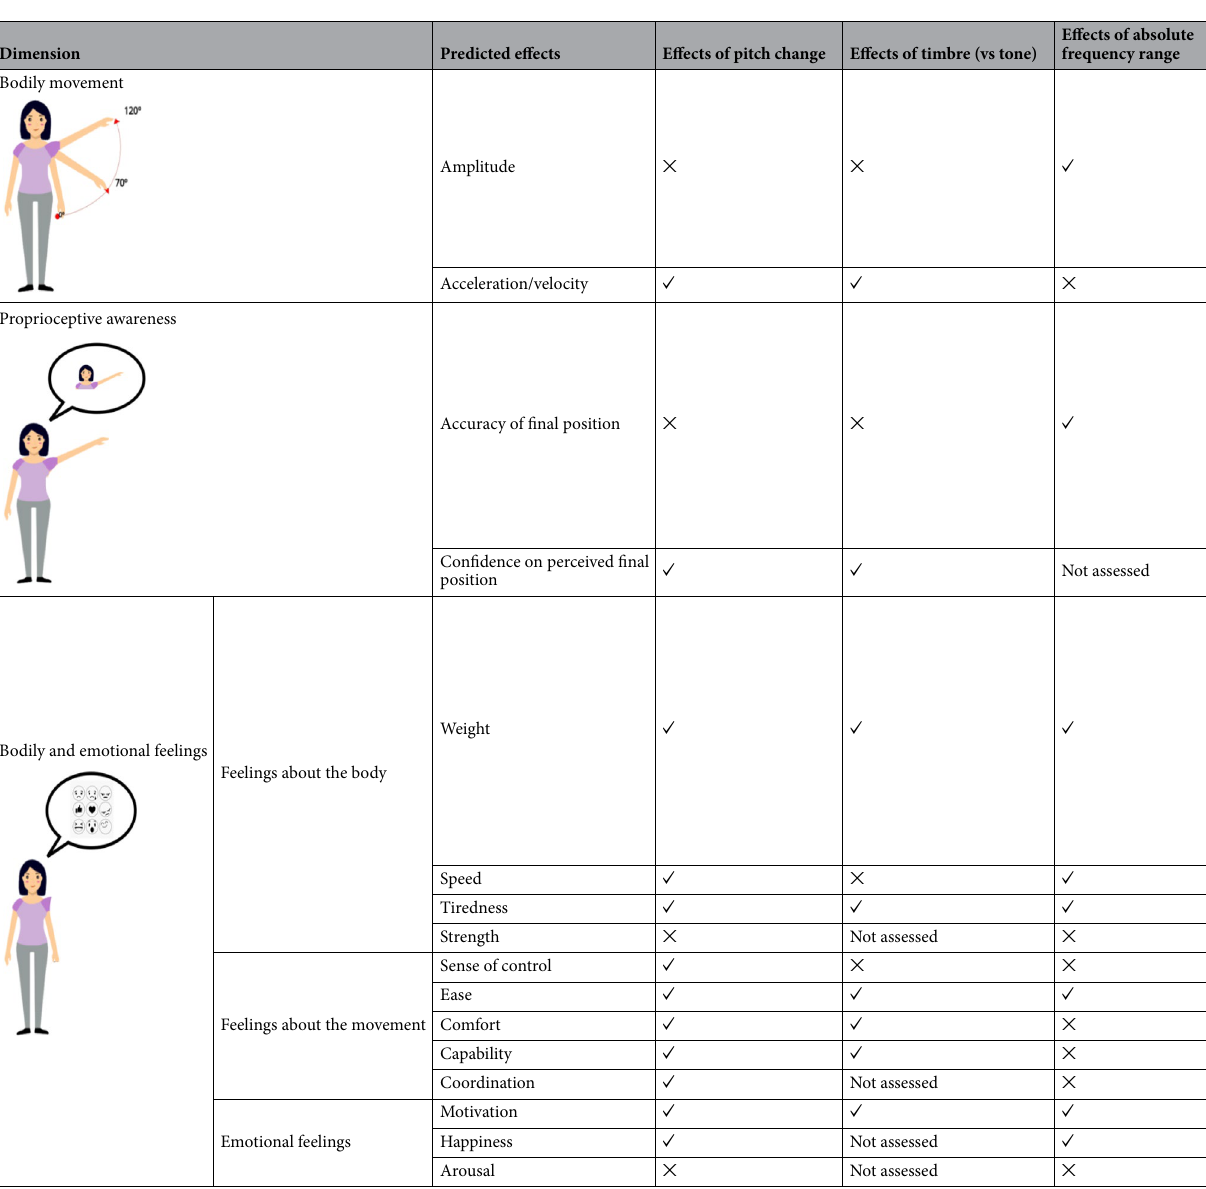
Table 3. Schematic summary of results on the effects across all the experiments (for a detailed summary of results see Supplementary Table